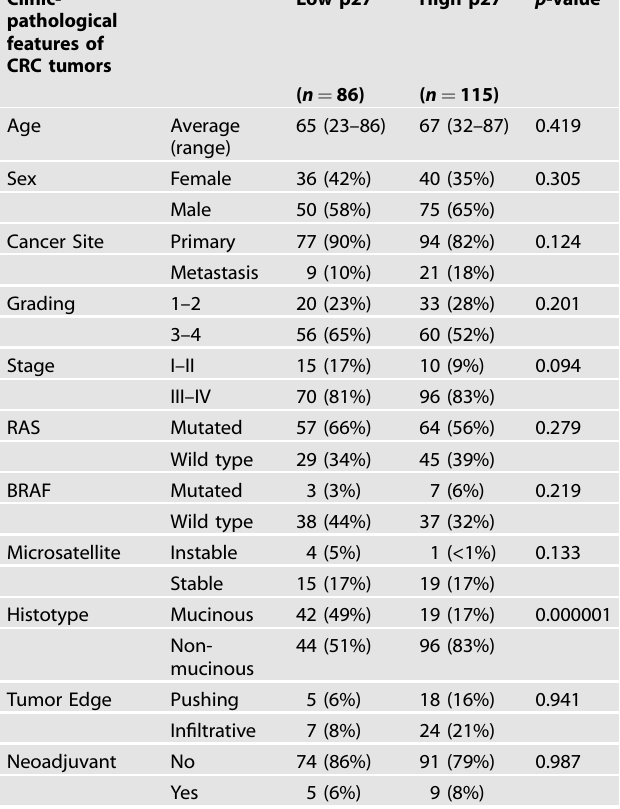
Table 1. Clinical and pathological features of CRC samples. Table describes the distribution of human colorectal tumors collected at University of Rome "Sapienza", according to high/low levels of p27 respect to the expression average (52% of neoplastic cells) and to the indicated clinico-pathological features. p-value was calculated using Fisher ’ s exact